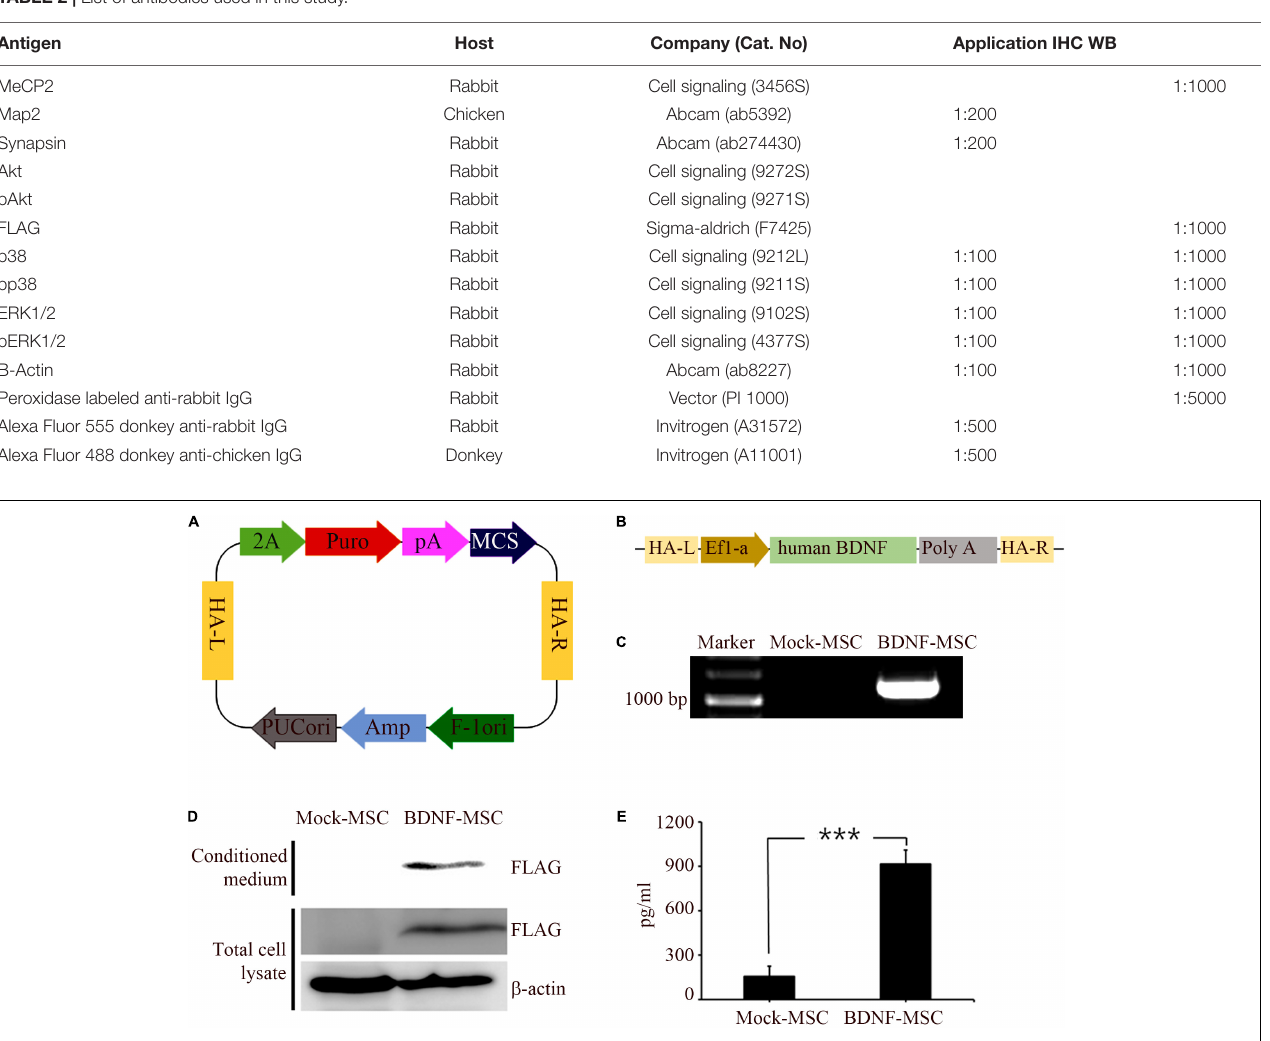
FIGURE 1 | Generation and characterization of BDNF secreting UCB-MSC. (A) pZDonor AAVS1 Puromycin vector. (B) Cloning of BDNF coding sequences, EF1 α promotor, and poly A tail. (C) Genome integration confirmed using Junction PCR with genomic DNA of UCB-MSCs, which were transfected with mock and BDNF containing pZDonor-AAVS1 vector. (D) Conditioned media and cell lysates from BDNF-secreting UC-MSCs tested using western blotting with FLAG antibodies. Only the transfection-derived BDNF protein can be detected using this method. (E) BDNF levels quantified using ELISA with BDNF antibodies. *** p <